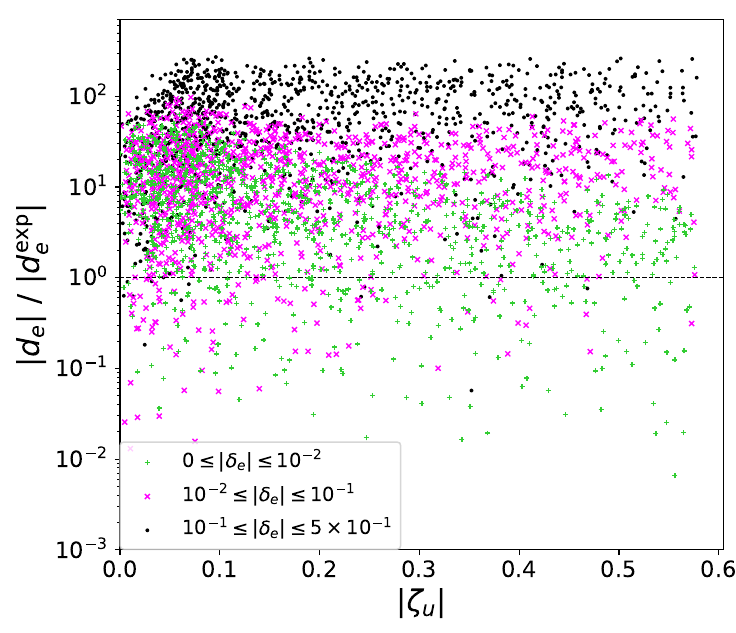
Figure 4 . The correlations between | ζ u | and | d e | / | d exp | . Input parameters are given by λ 2 = e 0 . 1 , m = 350 GeV , M = 30 GeV and v = 0 . 1 . We scan the other parameters for the regions Φ w of θ = θ = [0 , 2 π ) , | ζ = [0 , 0 . 6] , | ζ = | ζ = [0 , 10] , | λ = [0 . 5 , 1 . 0] and θ = [0 , 2 π ) . Black, u d u | d | e | 7 | 7 magenta and green points are the cases of 0 . 1 ≤ | δ 0 . 5 , 0 . 01 ≤ | δ 0 . 1 and 0 ≤ | δ 0 . 01 , e | ≤ e | ≤ e | ≤ respectively. Here, we have defined δ e ≡ θ u − θ e